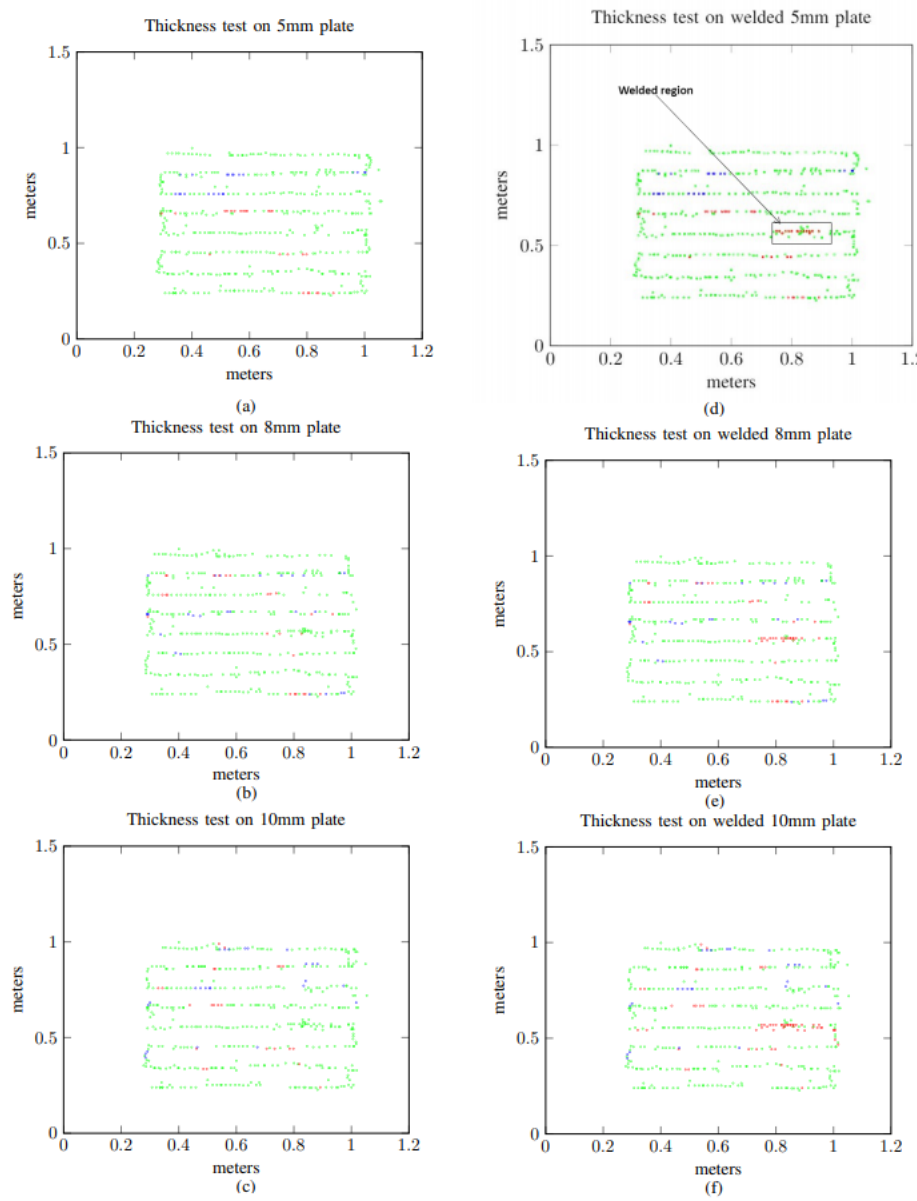
Figure 10. Thickness measurement test conducted on non welded and welded pates of different thickness. ( a ) Thickness test on 5 mm plate; ( b ) Thickness test on 8 mm plate; ( c ) Thickness test on 10 mm plate; ( d ) Thickness test on welded 5 mm plate; ( e ) Thickness test on welded 8 mm plate; ( f ) Thickness test on welded 10 mm